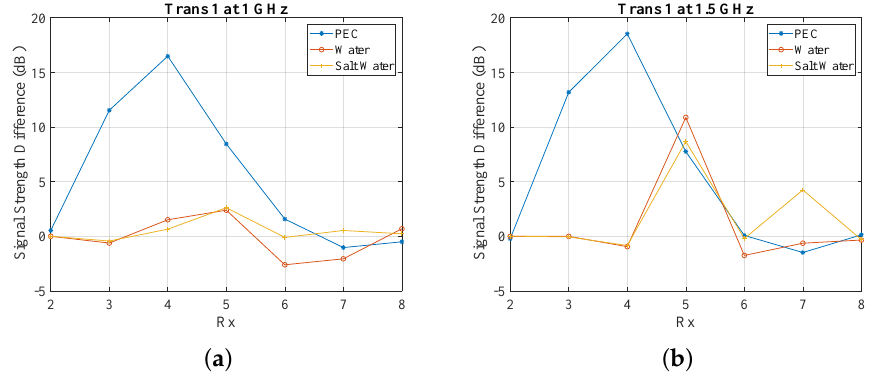
Figure 8. Differences in dB of received signal strength (No target–with target) as a function of receiver number when the array is immersed in 90% glycerine–water with metallic (PEC), water, and salt–water targets ( a ) at 1 GHz ( b ) at 1.5 GHz. Note that positive values in dB result from received signals that are reduced in the presence of the